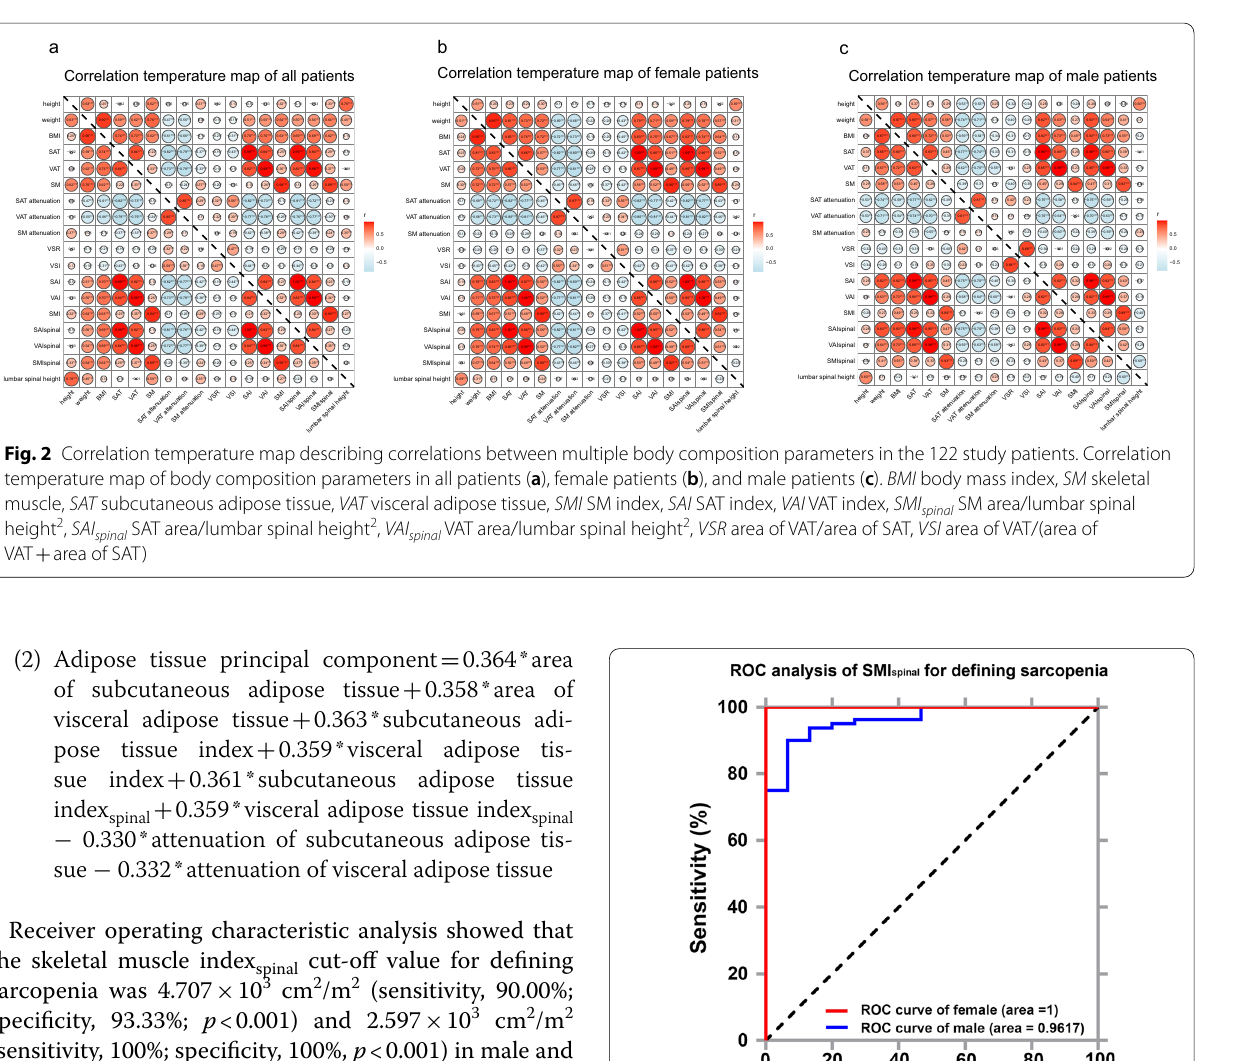
with lower values remained associated with more com- plicated disease behavior (Table 2). Skeletal muscle principal component was derived based on the area and attenuation of the skeletal muscle and skeletal muscle indexes. Thus, lower areas and attenuation of the skeletal muscle and skeletal muscle indexes were indicators of more complicated disease behavior.